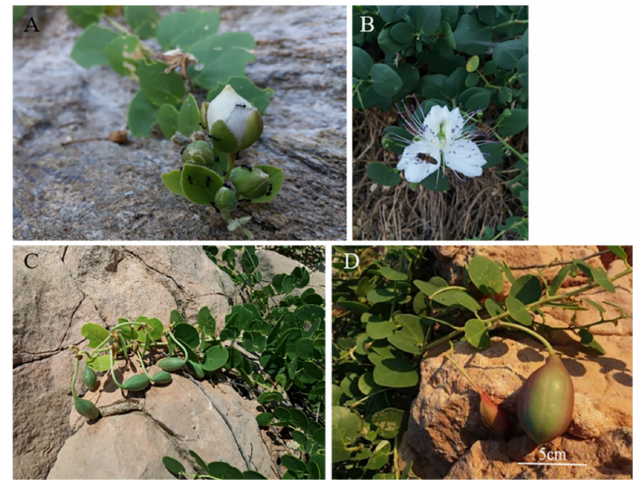
Figure 1. Representative views of the vegetative and reproductive growth of Capparis spinosa : ( A ) Stem with expanded and expanding leaves, and flower buds. ( B ) Flowering time at dusk; a range of floral traits including size, symmetry, odor, color and a pair of variegated petals with white marginal and green basal petal portions angled so as to face the sunrise, determine pollinator visitation in order to access reward from flower [18] of C. spinosa . ( C ) Stems, leaves and successive green immature fruits with pedicles. ( D ) Stem, leaves and a mature fruit—brownish and greenish—with pedicel, next to a detached and dehydrated substantially smaller fruit.